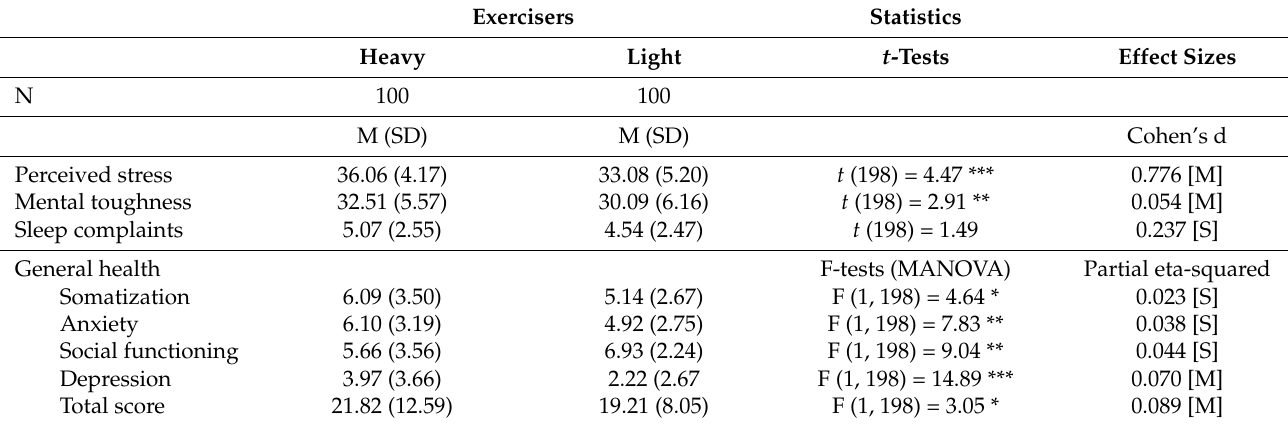
Table 3. Inferential statistical indices of general health, perceived stress, mental toughness, and sleep complaints between heavy and light exercisers.